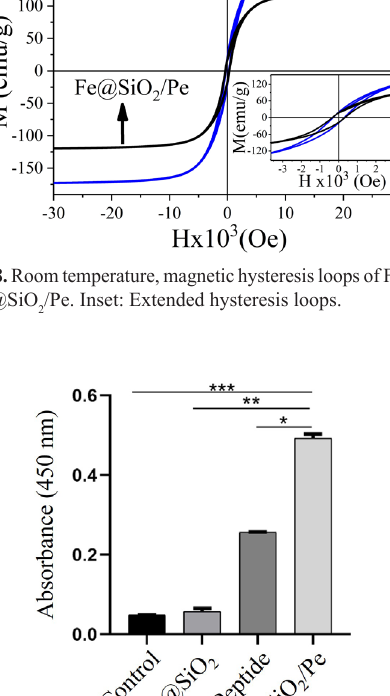
), s ) of the nZVIs. B Figure 9. Detection of functionalization of Fe@SiO with the biomarker peptide. The binding of the peptide to the Fe@ SiO nanoparticles was detected through a biotin-streptavidin-HRP 2 system. Data are expressed as normalized values ± SEM (n=2). Statistical differences were determined by Student’s t test: * p = 0.0010, ** p = 0.0004 and *** p =